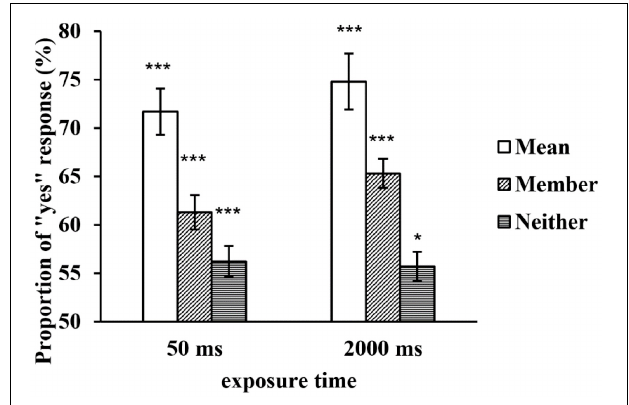
FIGURE 5 | The net proportion of “yes” responses to the test faces in a large set at two exposure